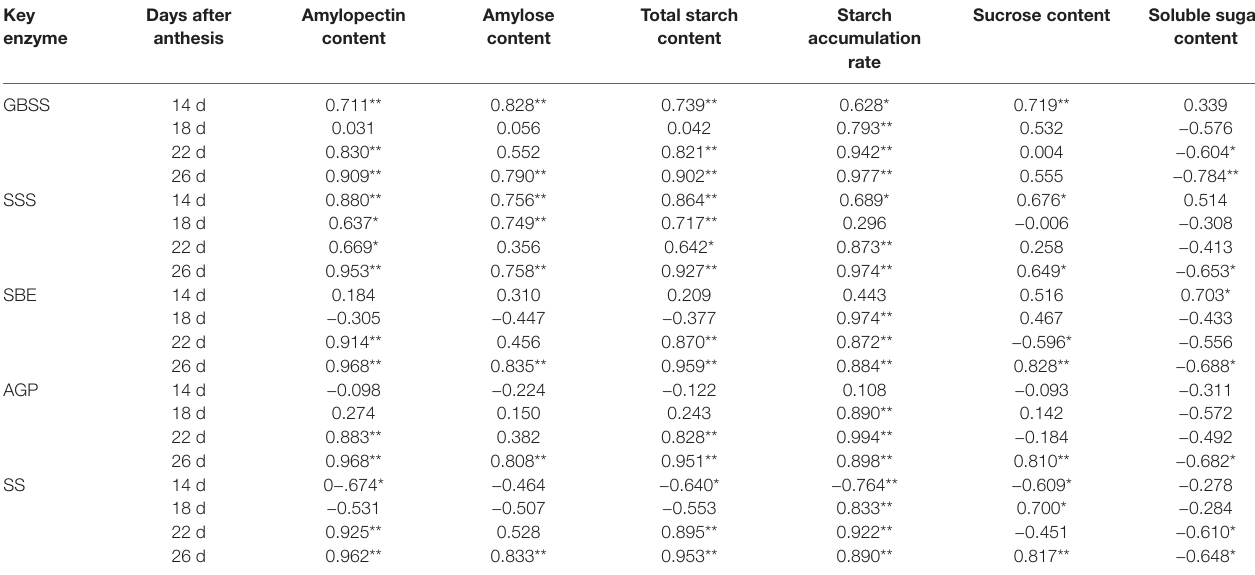
TABlE 5 | Correlation analysis between the activities of key starch biosynthesis enzymes and the dynamic accumulation of starch, sucrose, and soluble sugars. Key Days after enzyme anthesis